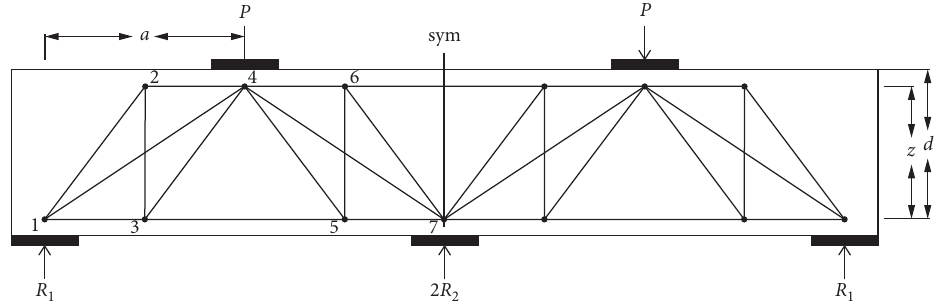
Figure 12: Indeterminate truss model for the two-span continuous deep beam [34].